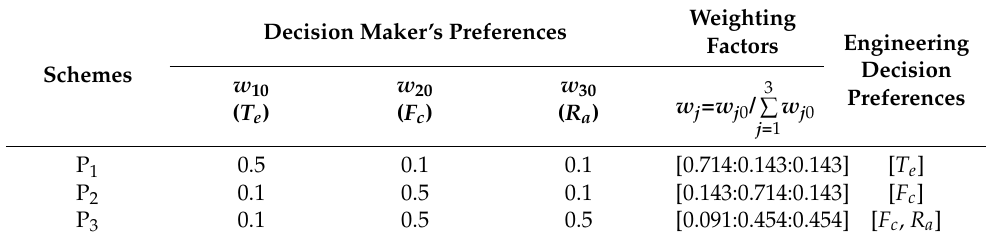
Weighting Factors Engineering Decision Preferences